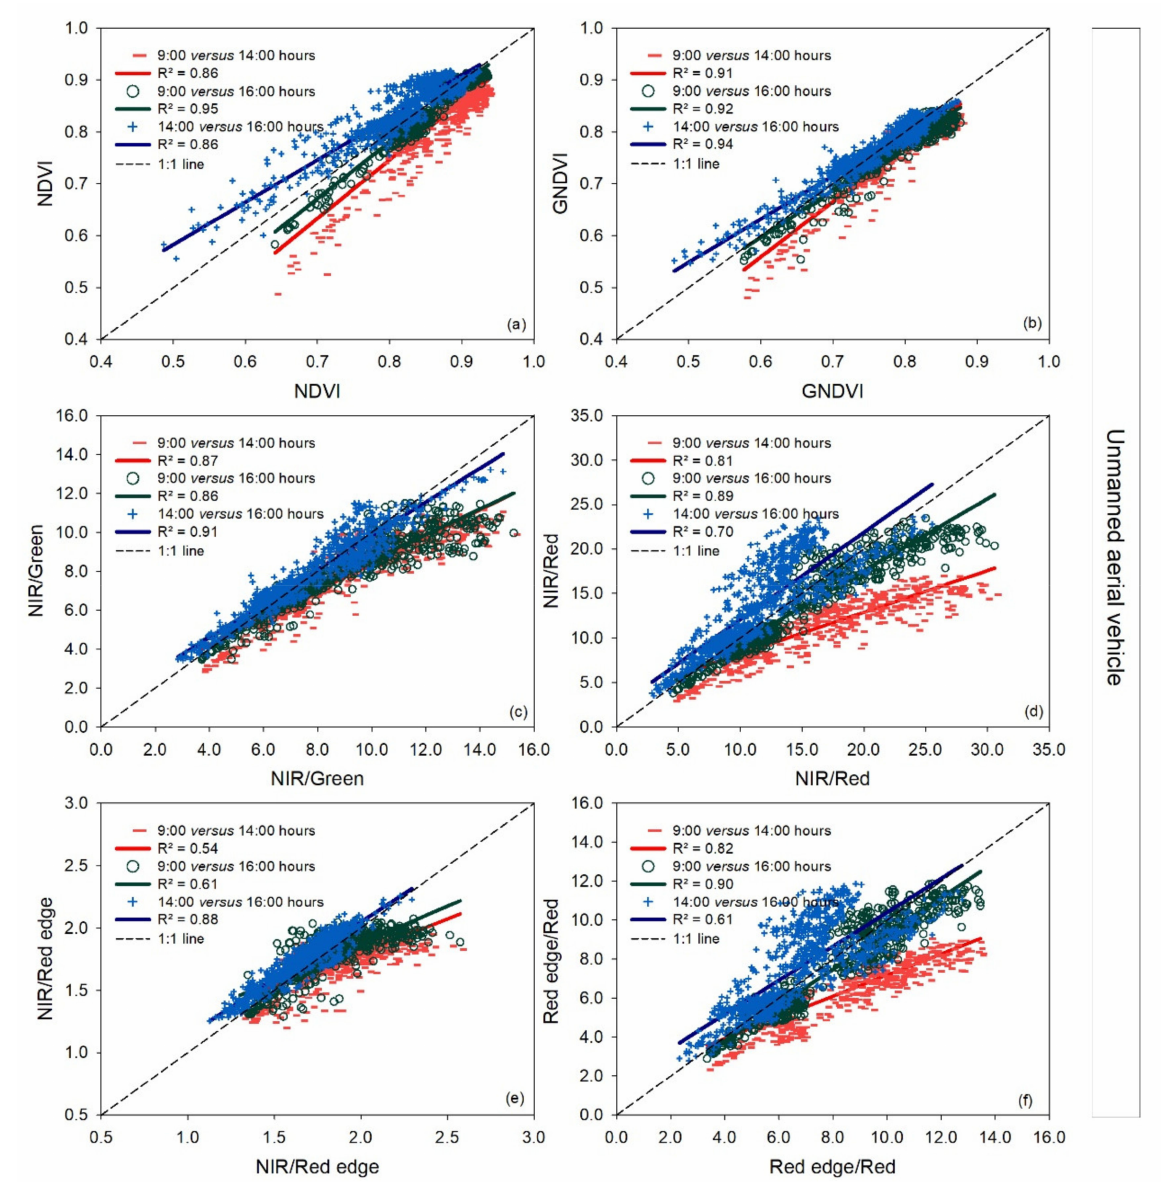
Figure 3. Linear regressions between paired measurement times (9:00 versus 14:00 h, 9:00 versus 16:00 h, and 14:00 versus 16:00 h) for each vegetation index measured with a UAV for the three measurement dates together. R 2 : coefficient of determination. The dashed line represents the 1:1 line. In the pairwise comparison, the earlier time is indicated on the x-axis and the later time on the y-axis ( a – f